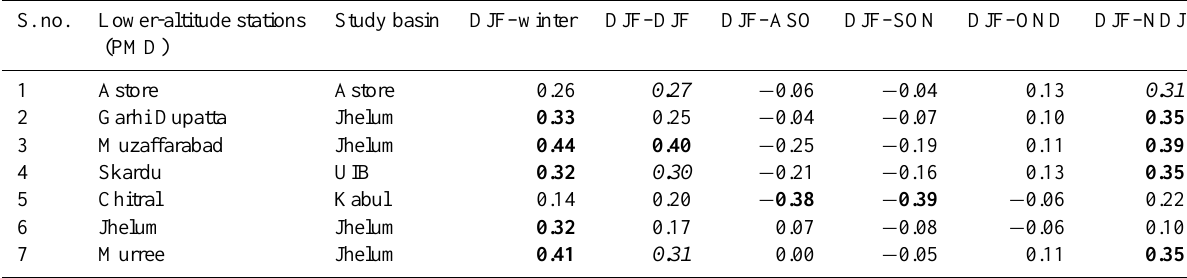
Table 10. Correlations between the NAO index and the long-term precipitation from PMD meteorological stations (1961–2000) within the studied basins. Only those stations which feature a statistically significant correlation of greater than or equal to 0.3 for at least one of the seasons are presented here. Correlations significant at the 90% level are marked in italic, and at the 95% level are marked in bold. S. no.